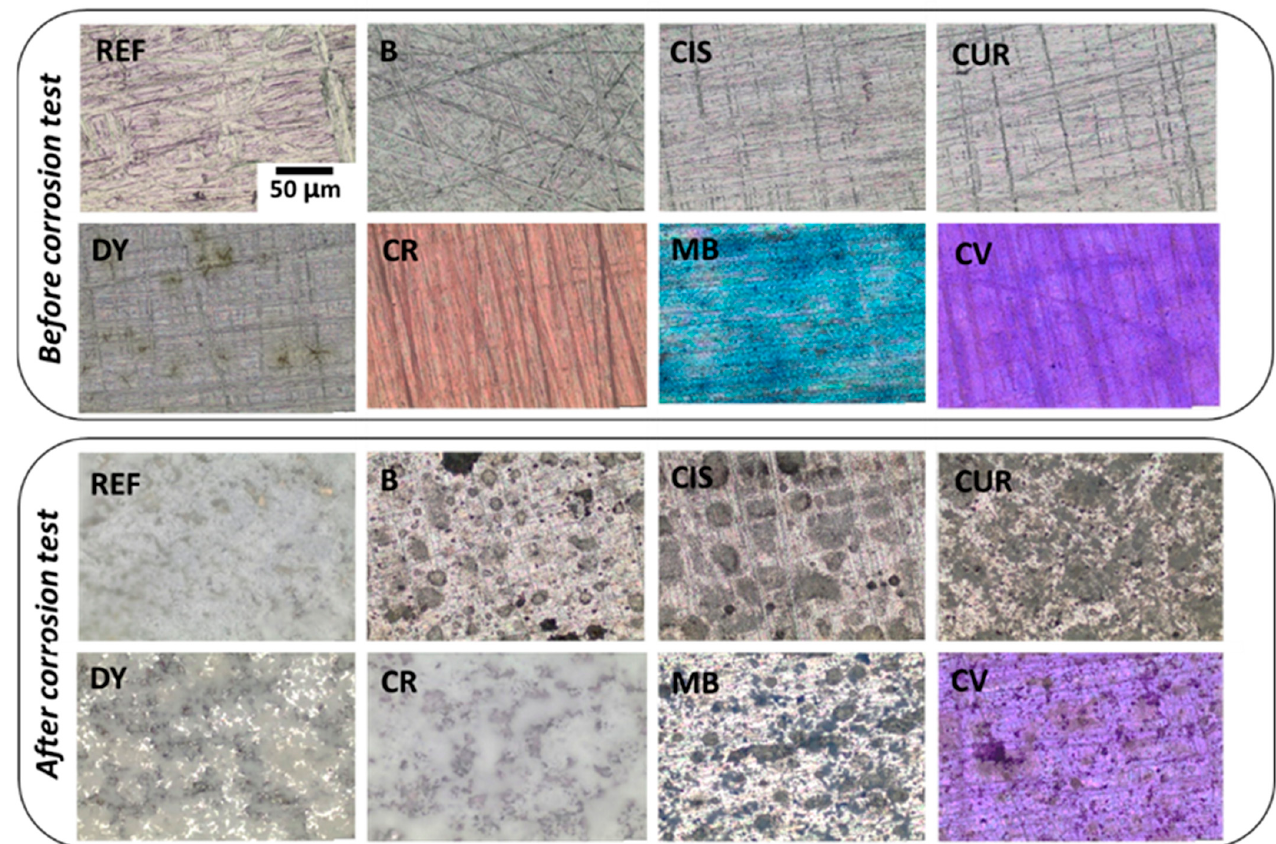
Figure 4. OM images of the sol-gel coated samples: before and after the corrosion test.